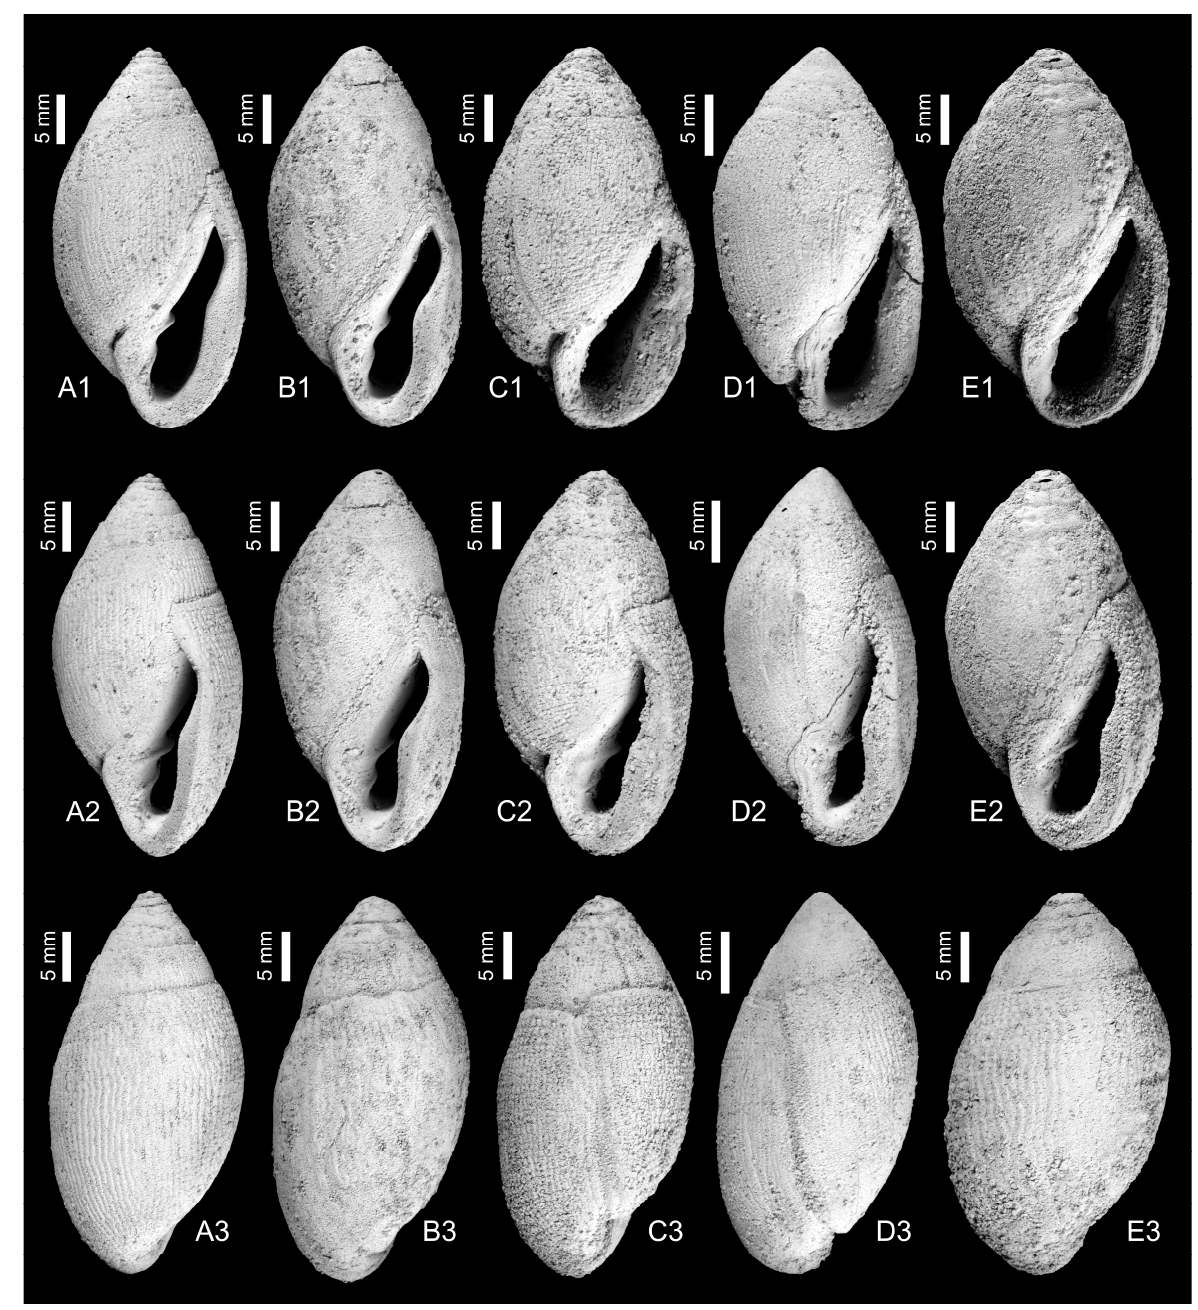
Figure 3. Chattian (Late Oligocene) Ellobium species: ( A1 – E3 ). Ellobium kerwaense nov. sp. ( A1 – A3 ). NHMW 2022/0285/0001, holotype, ( A1 ) apertural view, ( A2 ) oblique apertural view, ( A3 ) dorsal view; ( B1 – B3 ). 2022/0285/0002, paratype, ( B1 ) apertural view, ( B2 ) oblique apertural view, ( B3 ) dorsal view; ( C1 – C3 ). 2022/0285/0003, paratype, ( C1 ) apertural view, ( C2 ) oblique apertural view, ( C3 ) dorsal view; ( D1 – D3 ). MNHN.F.A87731, paratype, ( D1 ) apertural view, ( D2 ) oblique apertural view, ( D3 ) dorsal view; ( E1 – E3 ). MNHN.F.A87732, paratype, ( E1 ) apertural view, ( E2 ) oblique apertural view, ( E3 ) dorsal view; all specimens Máriahalom, Hungary. Holotype. NHMW 2022/0285/0001, shell height: 38.7 mm, diameter: 20.4 mm (Figure 3(A1–A3)). Paratypes. NHMW 2022/0285/0002, shell height: 38.9 mm, diameter: 19.8 mm (Figure